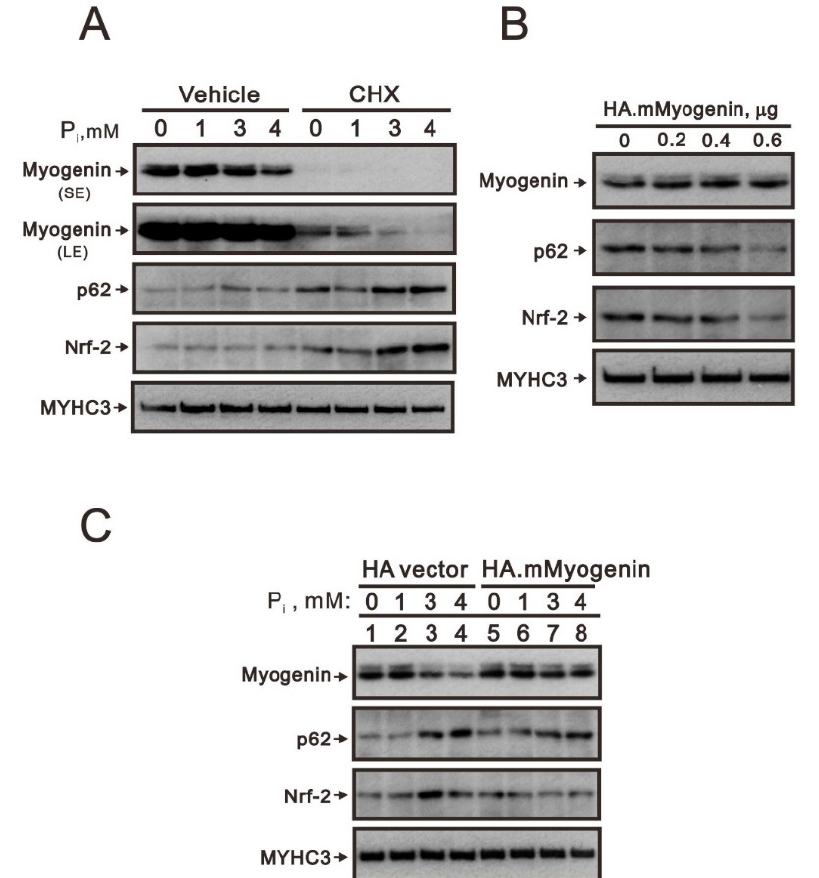
Figure 1. The effects of myogenin induced by high P i on Nrf2 and p62 proteins in differentiated C2C12 cells. ( A ) After induction of differentiation by culturing C2C12 cells in differentiation medium for 3 days, differentiated C2C12 cells were pretreated for 2 h with CHX (5 μ g/mL) and then were treated for 24 h with the indicated concentrations of P i . ( B ) Differentiated C2C12 cells were transiently transfected with indicated amounts of pSG5.HA. Myogenin for 4 h and further cultured for 20 h. ( C ) Differentiated C2C12 cells were transiently transfected with indicated amounts of pSG5.HA.Myogenin for 4 h and then treated with the indicated concentrations of P i for 20 h. ( A – C ) Immunoblot analysis of myogenin, p62, Nrf2, and MYHC3 (myosin heavy chain isoform 3) levels. MYHC3 was a protein loading control. SE: shorter exposure; LE: longer exposure.